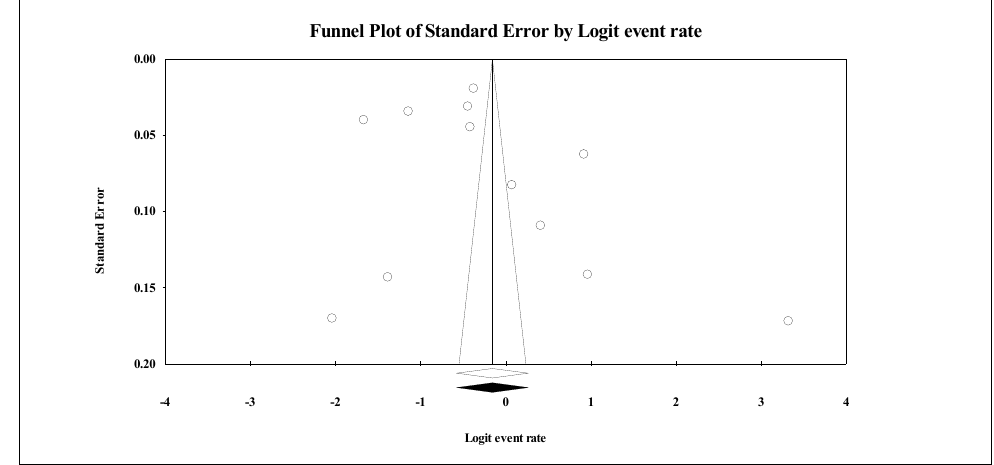
Figure A12. Funnel plot for studies on the prevalence of psychological distress (Egger test: P = 0.45; Begg test: P = 0.73). The vertical solid line represents the summary effect estimates.